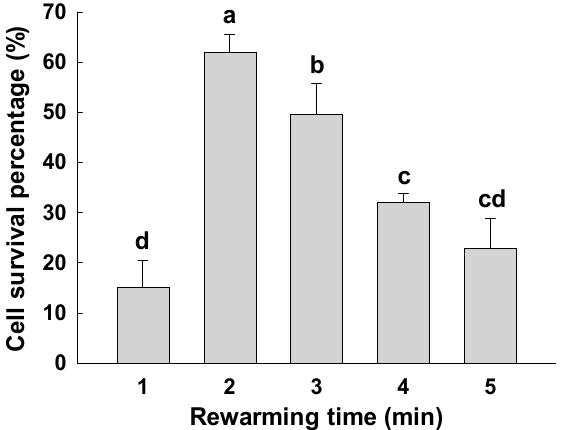
Table 6. Effect of rewarming time on fresh weight of F. mandshurica EC after cryopreservation by